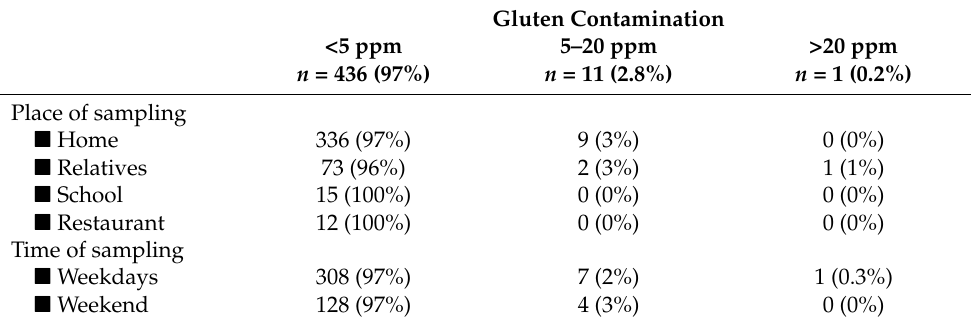
Table 2. Gluten contamination level according to food samples features.